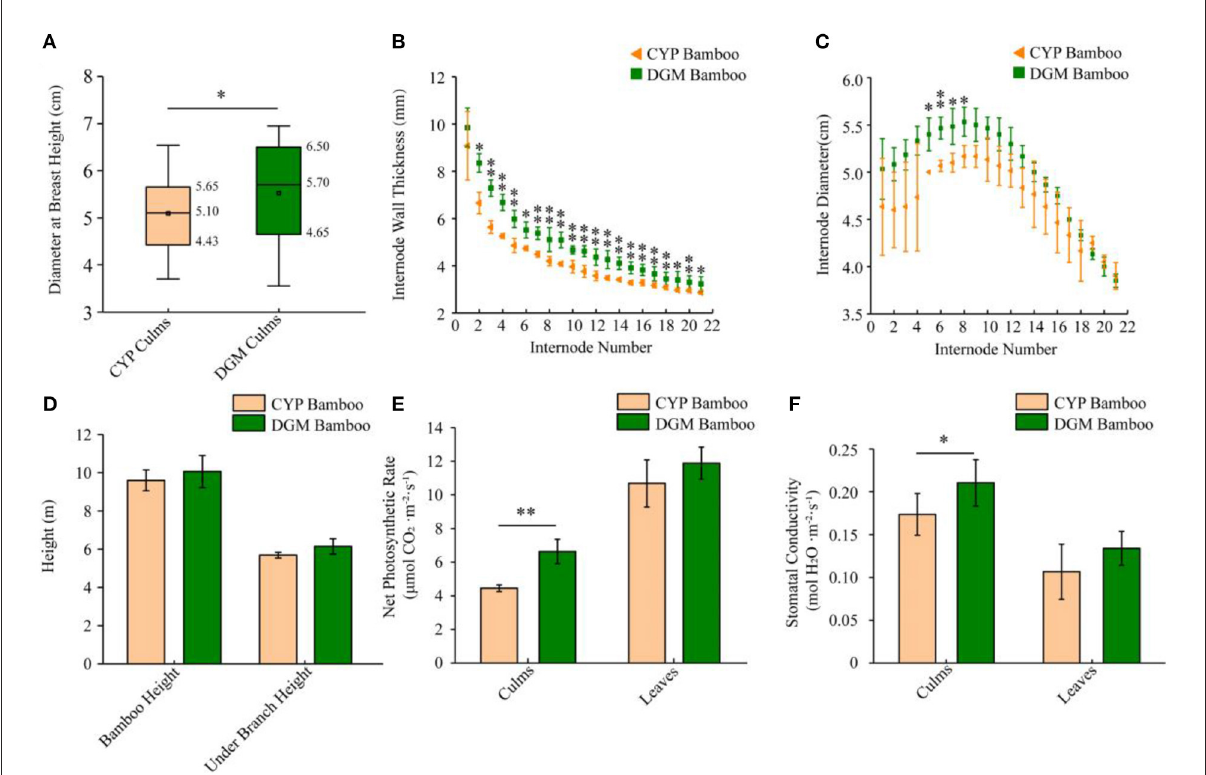
FIGURE1 Phenotypic characteristics of CYP and DGM bamboos of P. vivax . (A) Average DBH of CYP and DGM culms. (B) Average IWT of one year old culms under branch. (C) Average ID of one year old culms under branch. (D) Average bamboo height and under branch height of one year old CYP and DGM culms. (E) Net photosynthetic rate of culms and leaves of CYP and DGM bamboos. (F) Stomatal conductance of culms and leaves of CYP and DGM bamboos. Data is presented as the mean ± standard deviation. Statistical analyses were performed by student’s t -test. *0.01 ≤ p ≤ 0.05 and ** p <